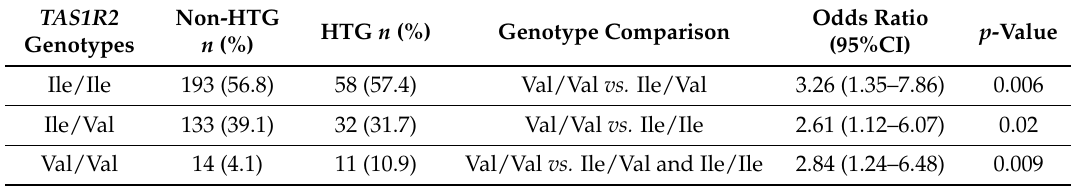
Table 5. Association of the TAS1R2 genotype with